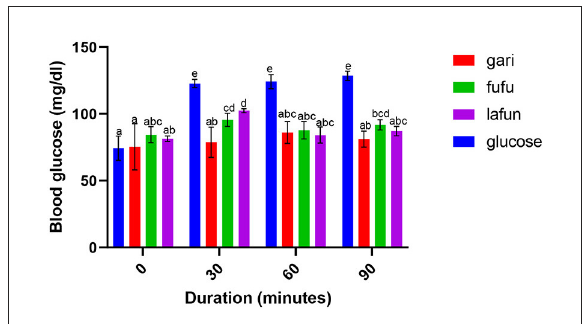
FIGURE6 Blood glucose response after the intake of fufu, lafun and gari from IITA-TMS-IBA183044. Mean values with different letters are significantly different at p <